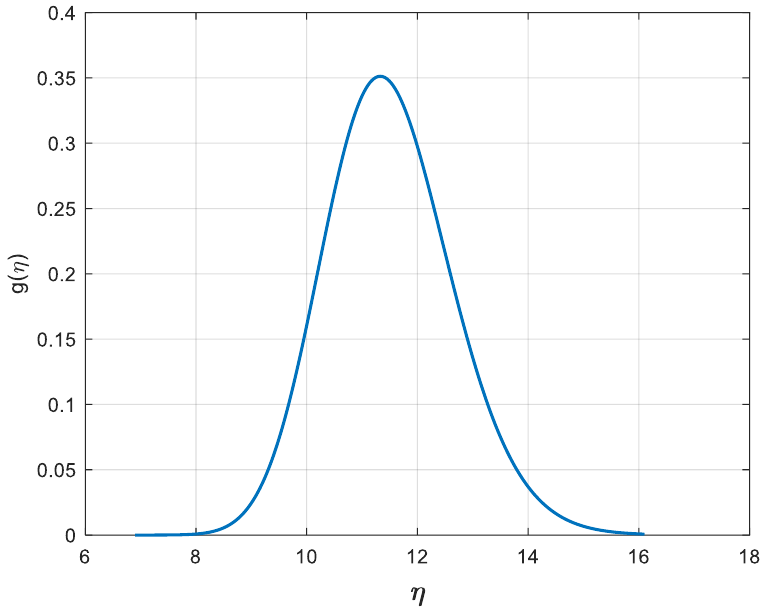
Figure 5. Lognormal prior PDF of η in case A2, with mean 11.5 m/s and CV = 0.10 (as in Equation (36), with parameter values: γ = 2.4374; β = 0.0998).